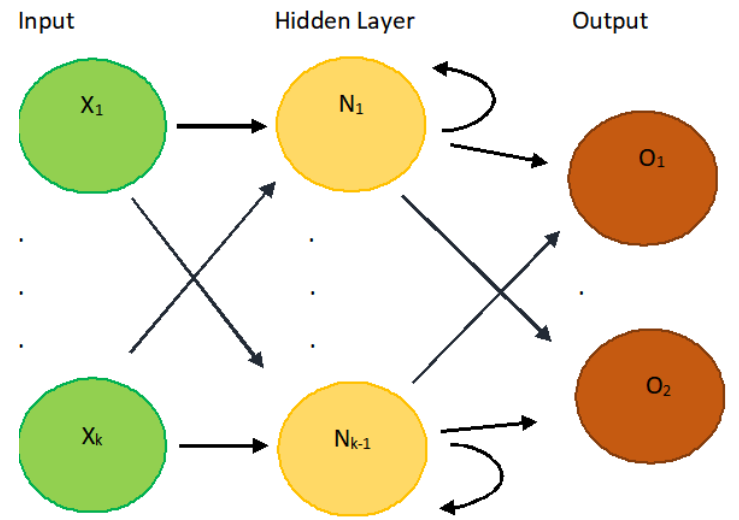
Figure 5. RNN and LSTM outline.